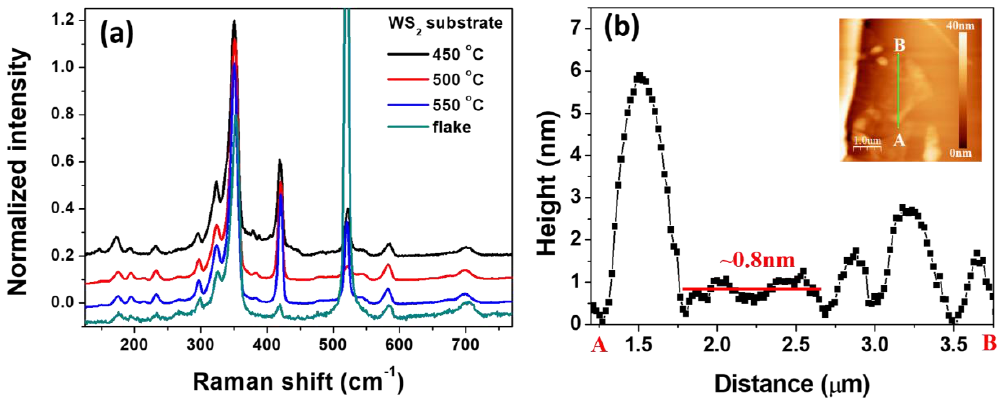
Figure 6. ( a ) Raman spectra of 2D WS 2 nanosheets substrates and monolayer WS 2 flake substrate. Spectra are offset for clarity. ( b ) AFM topography line profile results of a WS 2 flake sample, showing the WS 2 flake sample is monolayer WS 2 .